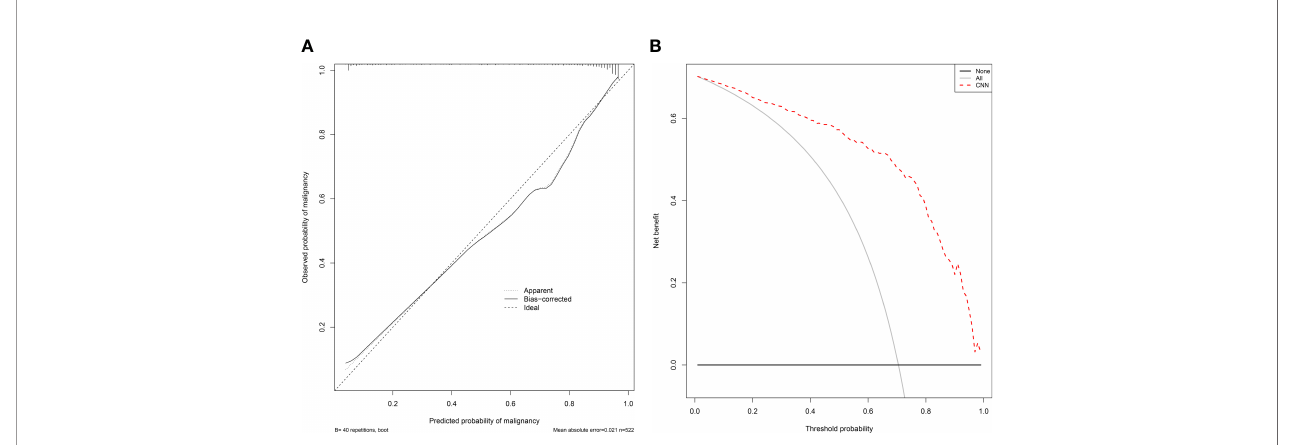
FIGURE 3 | The calibration curve and decision curve of the CNN model for malignancy prediction. (A) The calibration curve of the CNN model (AdaDense_M) for malignancy prediction. The diagonal dotted line represents a perfect prediction by an ideal model. (B) The decision curve of the CNN model (AdaDense_M) for malignancy prediction. The gray solid line represents the assumption that all patients had malignant nodules. The black solid line represents the assumption that no patients had malignant nodules. The net bene fi t was calculated by subtracting the proportion of all patients who are false positive from the proportion who are true positive, weighting by the relative harm of a false-positive and a false-negative result.